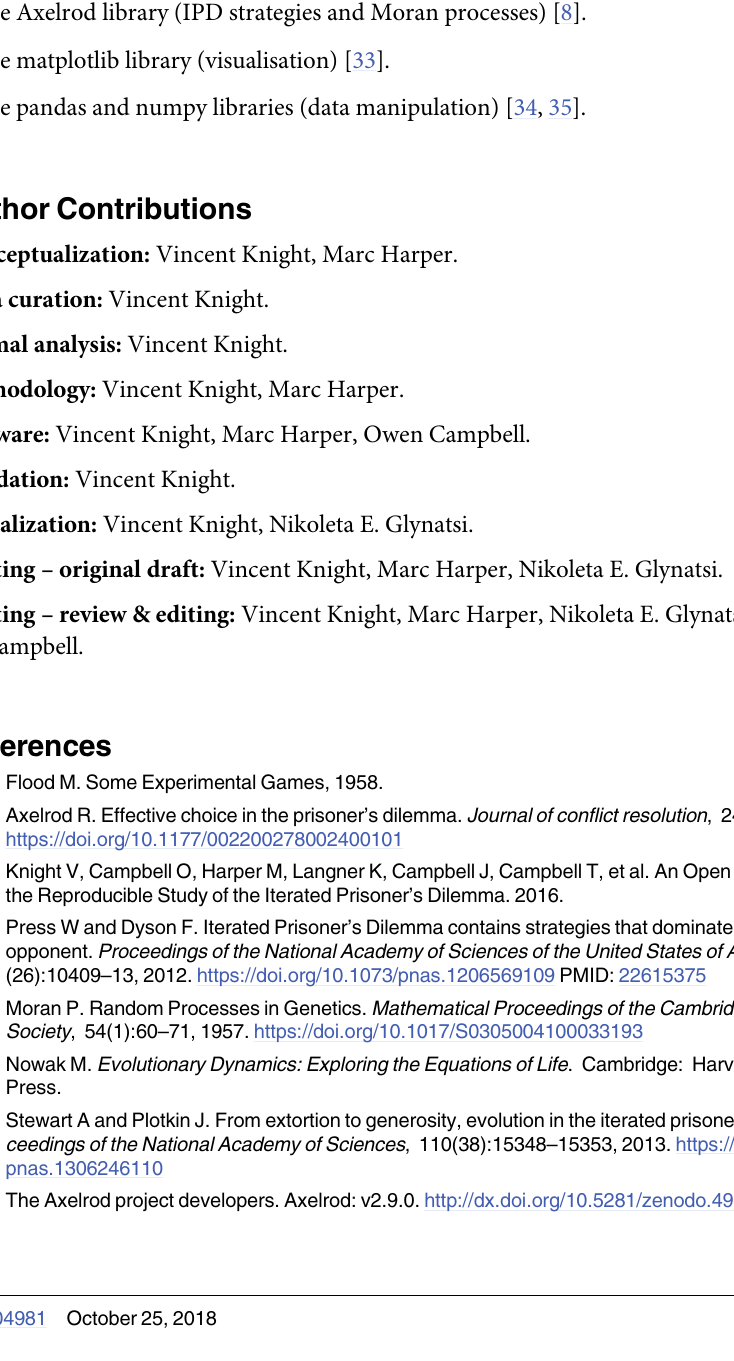
for N = 13. N − 1 for N = N − 1